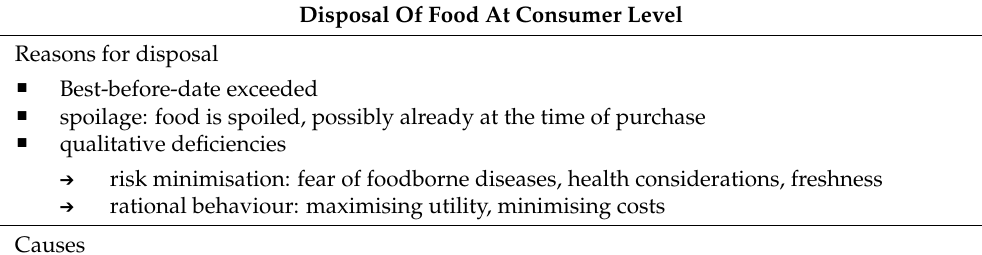
Table 2. Reasons, causes, and driving forces behind disposal at consumer